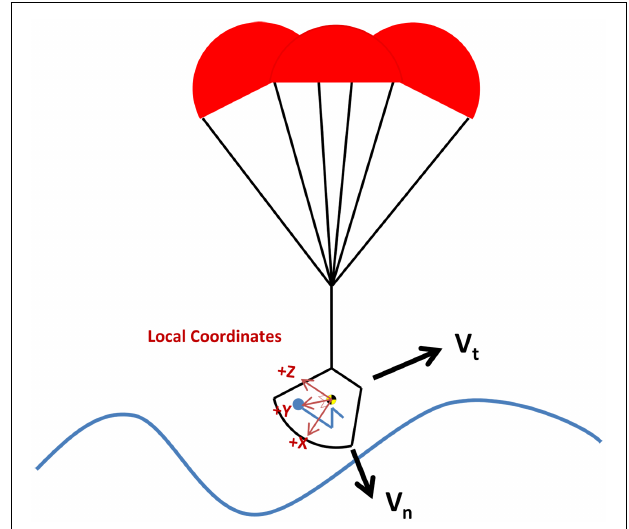
FIGURE 1 | Nominal capsule landing orientation with respect to water (land landing similar)